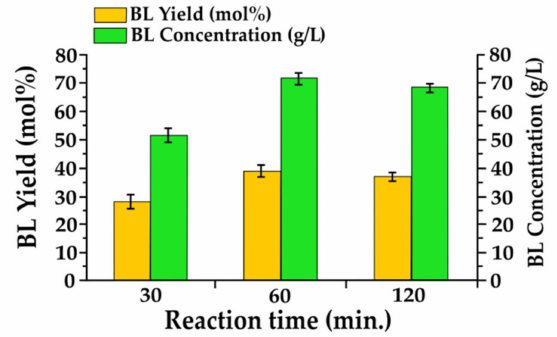
Figure 6. Kinetics of the one-pot butanolysis of the ADW Eucalyptus nitens sample (20 wt%) to BL. Reaction conditions: biomass loading 20 wt%, 190 ◦ C, H 2 SO 4 1.2 wt%, TR